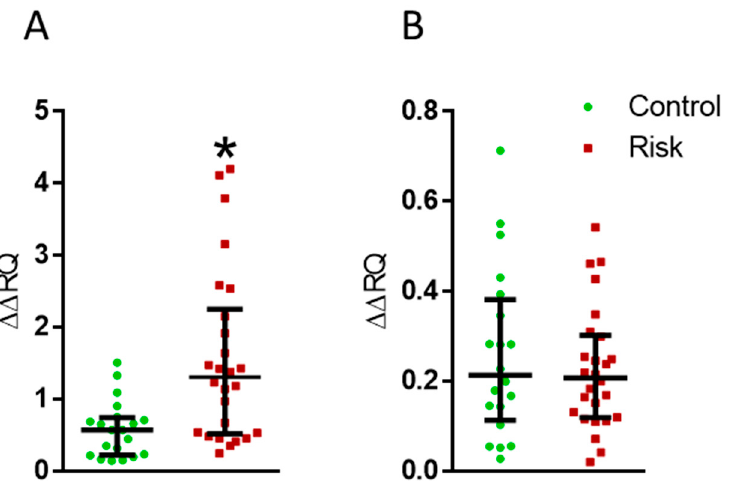
Figure 9. Changes in the expressions of the dopamine D3 ( A ) and D4 ( B ) receptor genes in the patients at risk of developing Parkinson’s disease compared with the controls. ∆∆ RQ, the change in the expression of the D3 and D4 receptor genes with normalization to the housekeeping gene. * p < 0.05, statistically significant differences. Data presented as a median with an interquartile range and min–max values.